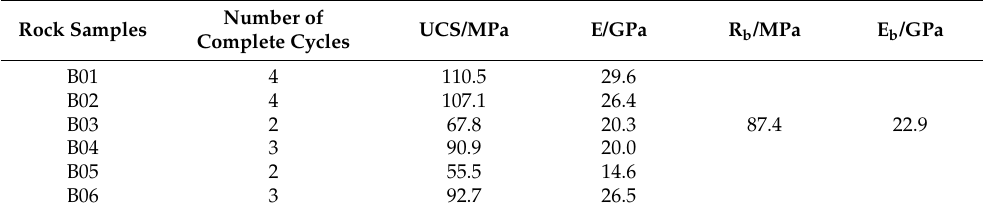
Table 3. Strength data of uniaxial graded cyclic loading and unloading tests of rock samples.